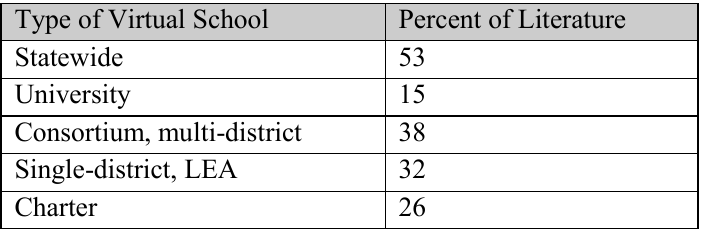
Percentage of Literature about Different Types of Virtual